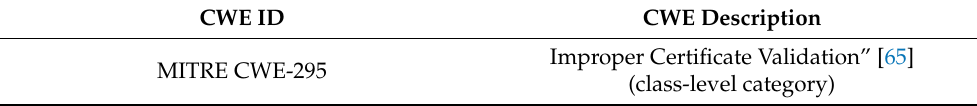
Table 2. MITRE Common Weakness Enumerations (CWEs) related to Improper Certificate Validation.